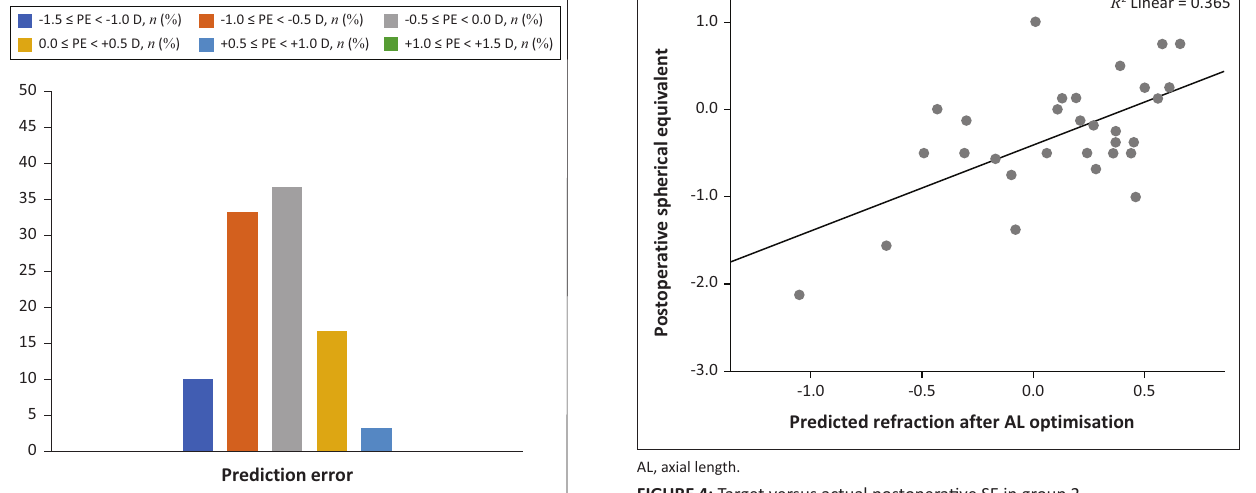
FIGURE 4: Target versus actual postoperative SE in group 2.